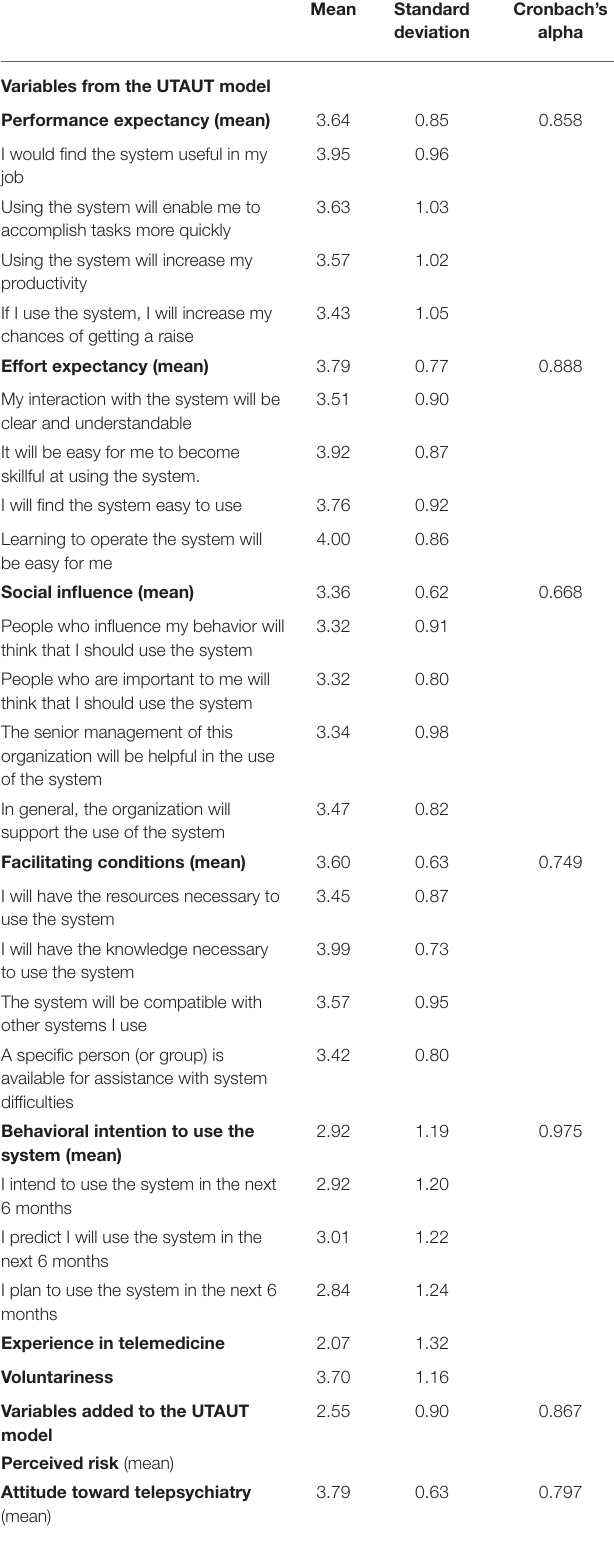
TABLE 3 | Descriptive statistics from the survey used in the present study. TABLE 4 | Linear regression of behavioral intention to use telepsychiatry on performance expectancy, age, and gender.